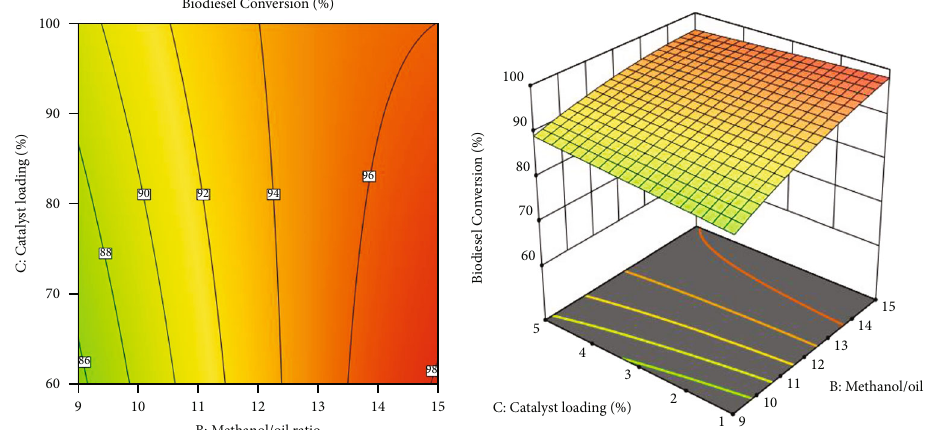
Figure 11: The link between biodiesel conversion, M:O ratio, and catalyst loading interactions is given as a contour and surface